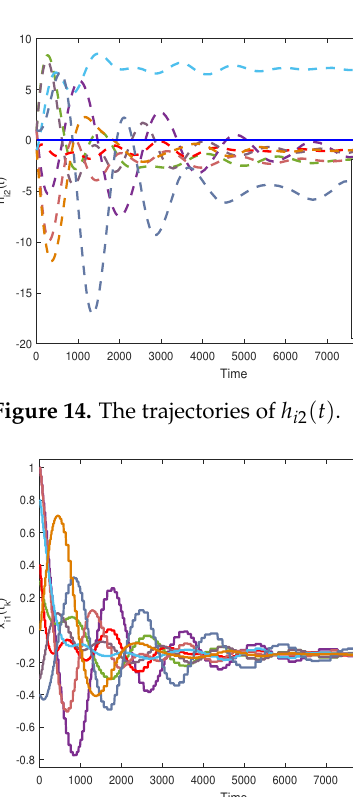
Figure 13. The trajectories of h i 1 ( t ) .